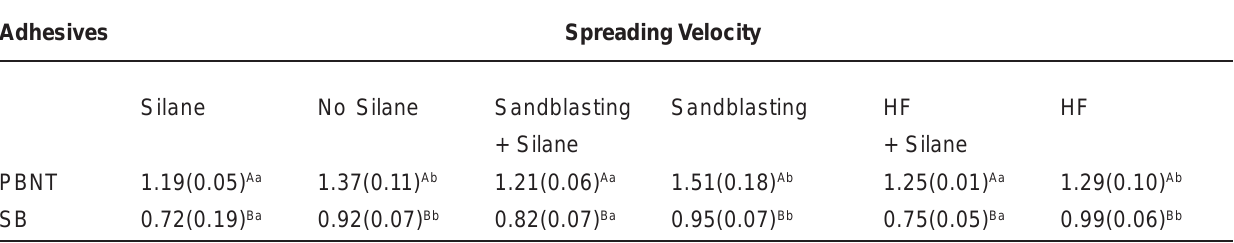
TABLE 2- Mean spreading velocity values of adhesive systems for each surface treatment, expressed in mm/s(sd) (n = 5) Mean values with the same letters (capital letter – column, lower case – line) are not statistically significantly different (p > 0.05)